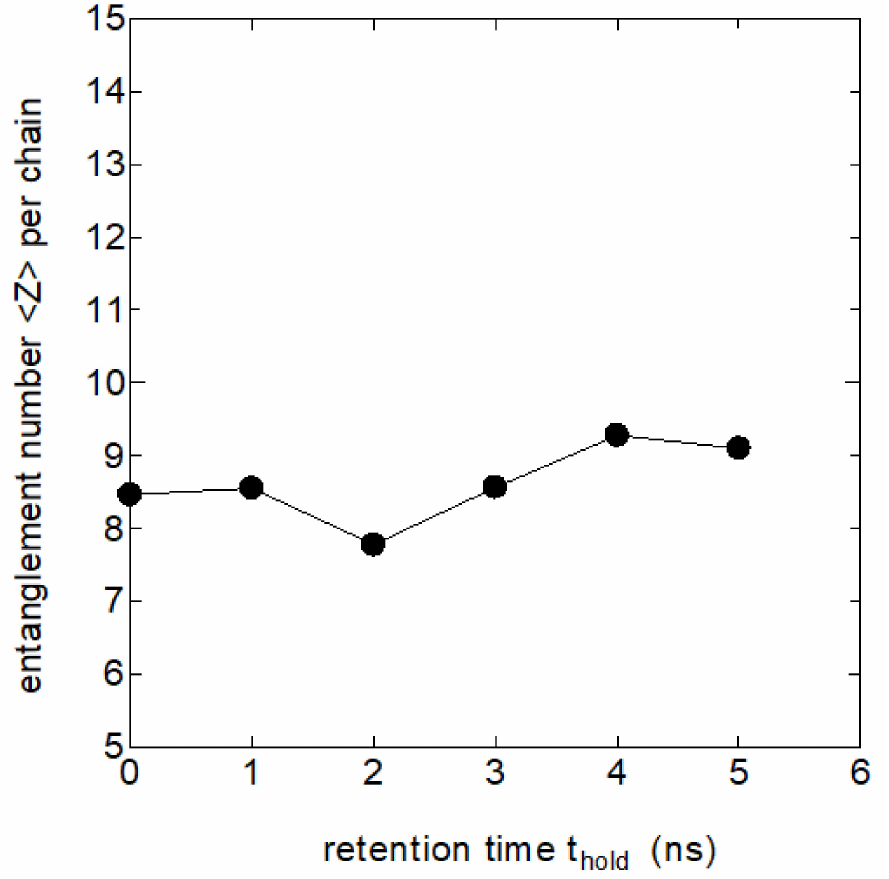
Figure 3. The number of entanglements per chain Z vs. the time of retention t hold at 440 K, where Z is estimated by the Z1-code by